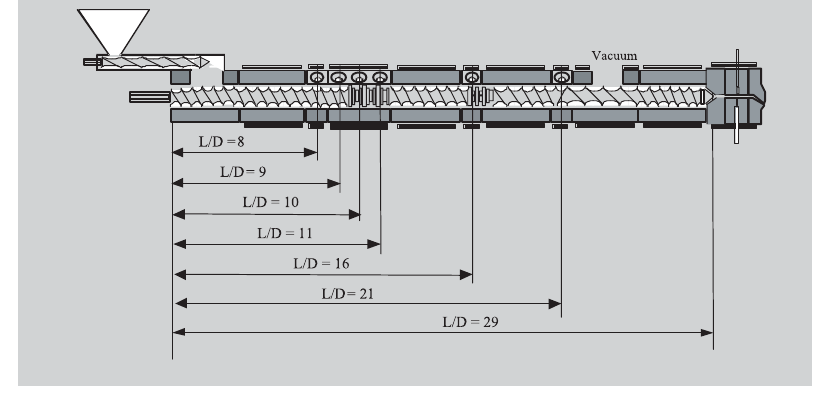
Figure 2 (left): Extruder layout and on-line measurements locations for the study of peroxide-induced, thermal degradation of poly- propylene. The polymer melts between L/D = 8 and L/D = 9. Figure 3 (right): Evolution of shear viscosity along the extruder for PP. The first number in the legend is the set barrel temperature and the second is the screw speed. Table 1 (right below): Pro- cessing conditions used for the study of PP